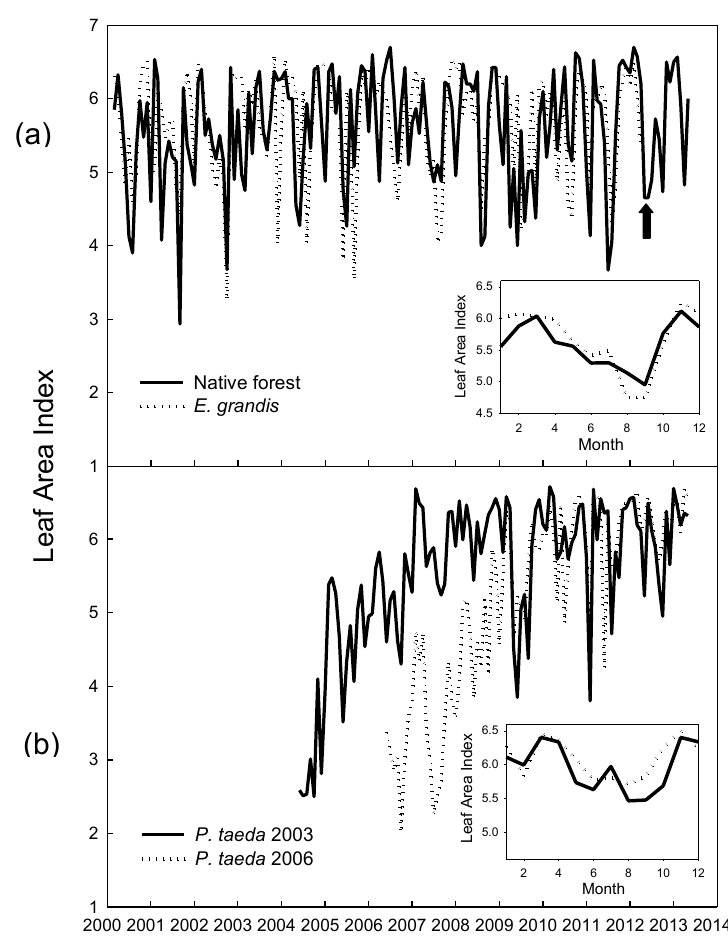
Figure 3. Monthly MODIS LAI (Leaf Area Index) from 2000 to 2013 of ( a ) a native forest and Eucalyptus grandis and ( b ) two tree plantations of Pinus taeda planted in different years. The black arrow in panel ( a ) indicates the time when the A. angustifolia and E. grandis plantations were cleared. Inset: annual dynamic of LAI obtained from the monthly averages of the: 2000 to 2013 time series for the native forest, 2000 to 2012 for E. grandis , and for 2009 to 2013 for both P. taeda species. Numbers 1 through 12 in the X -axis insets correspond to January through